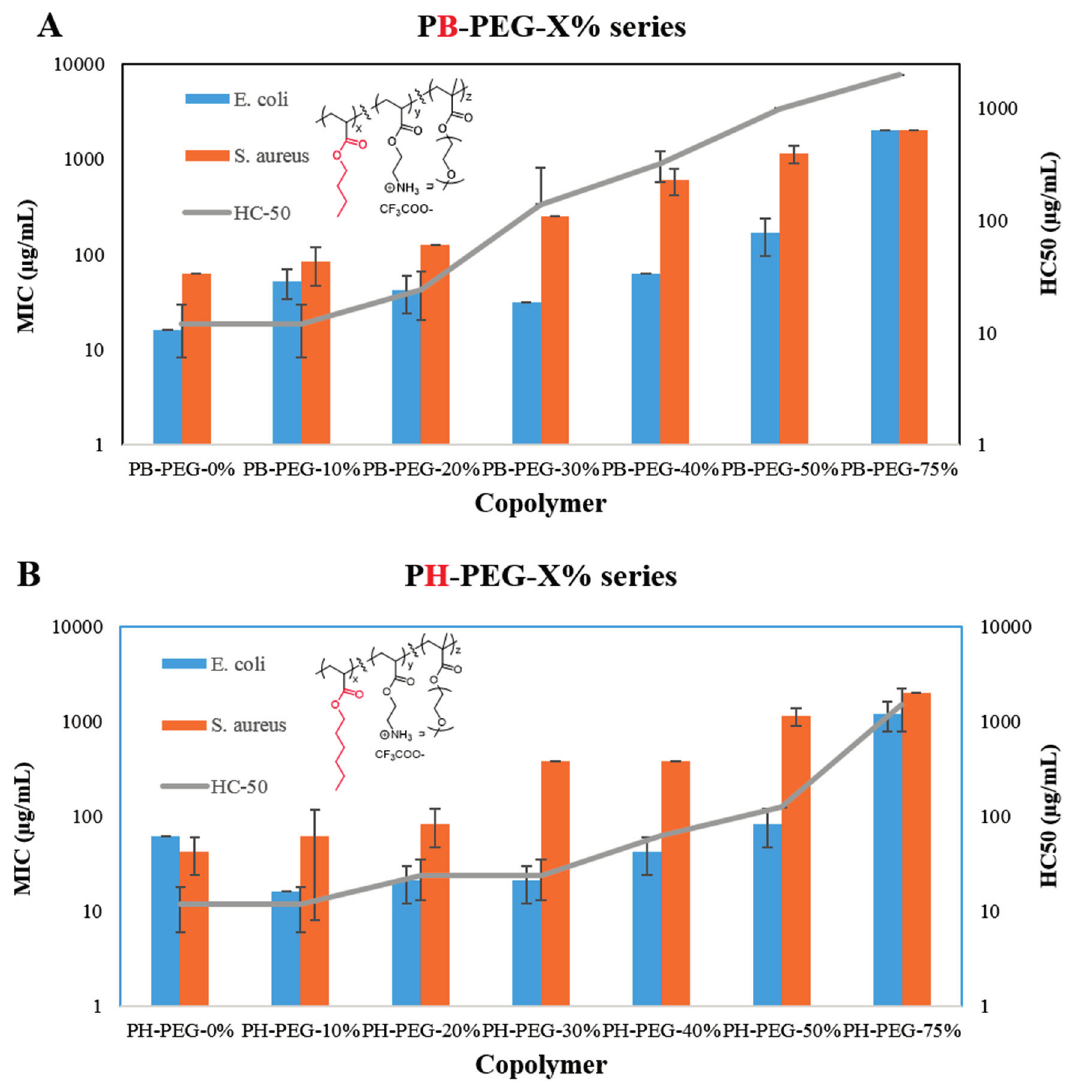
Figure 2. Antibacterial (MIC) and hemolytic activities (HC 50 ) of ( A ) PB-PEG-X% series, terpolymers of butyl acrylate (shown in red in structure), 2-(( tert -butoxycarbonyl)amino)ethyl acrylate, and PEGMA-300; ( B ) PH-PEG-X% series, terpolymers of hexyl acrylate (shown in red in structure), 2-(( tert -butoxycarbonyl)amino)ethyl acrylate, and PEGMA-300. Error bars represent standard